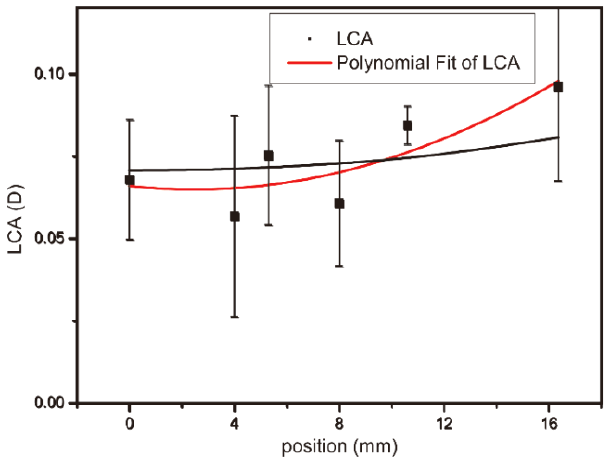
Fig. 6. (Color online) Dependence of the LCA as a function of the position. The black curve represents the calculations, while the red curve represents the ¯tting of the measured values. The black squares represent the mean values of the LCA for each measurement position, while the error bars represent the standard deviations.